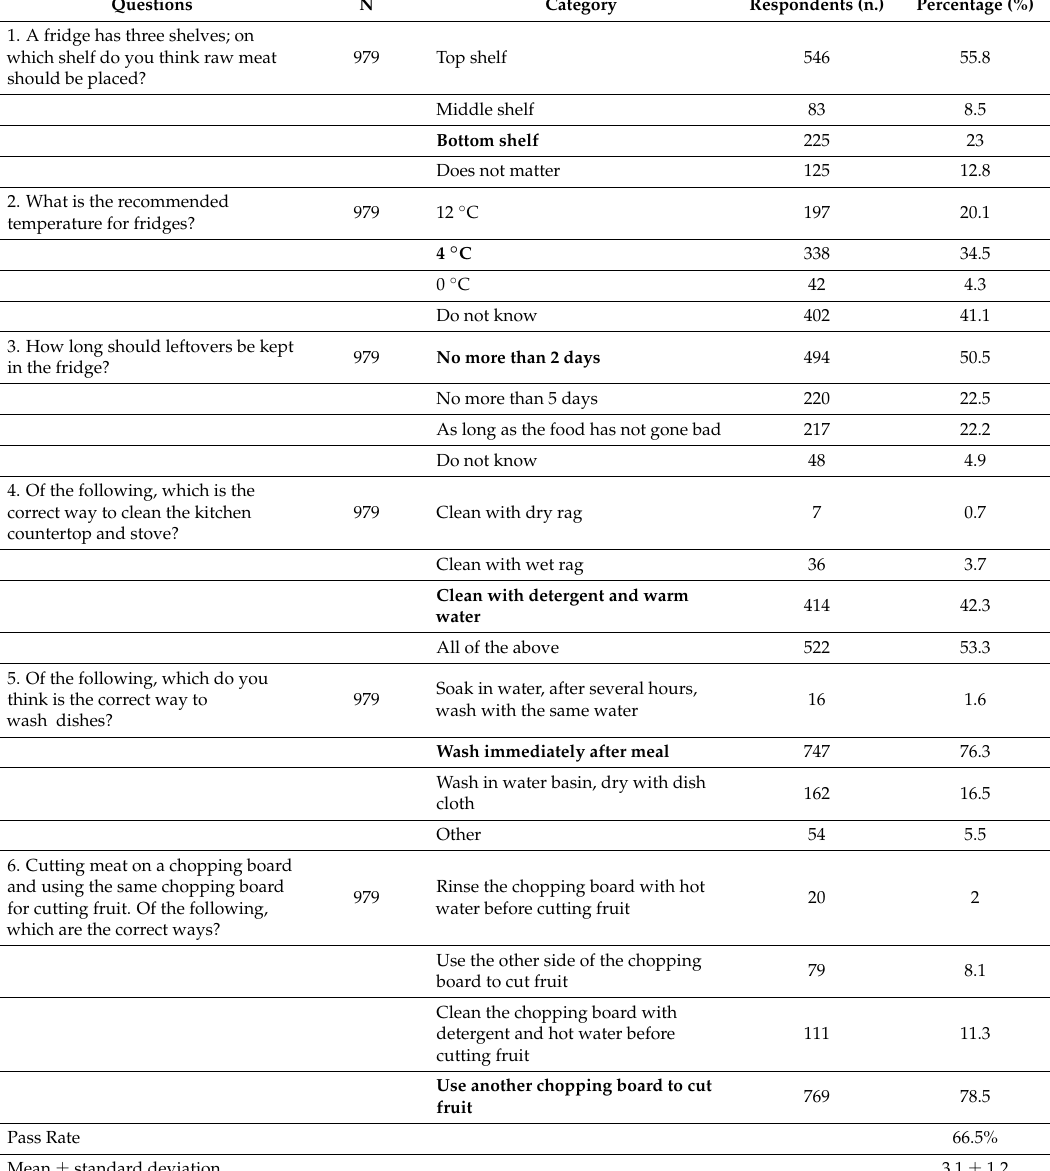
Table 4. Respondents knowledge on usage and maintenance of kitchen facilities, pass rate, mean score, and standard